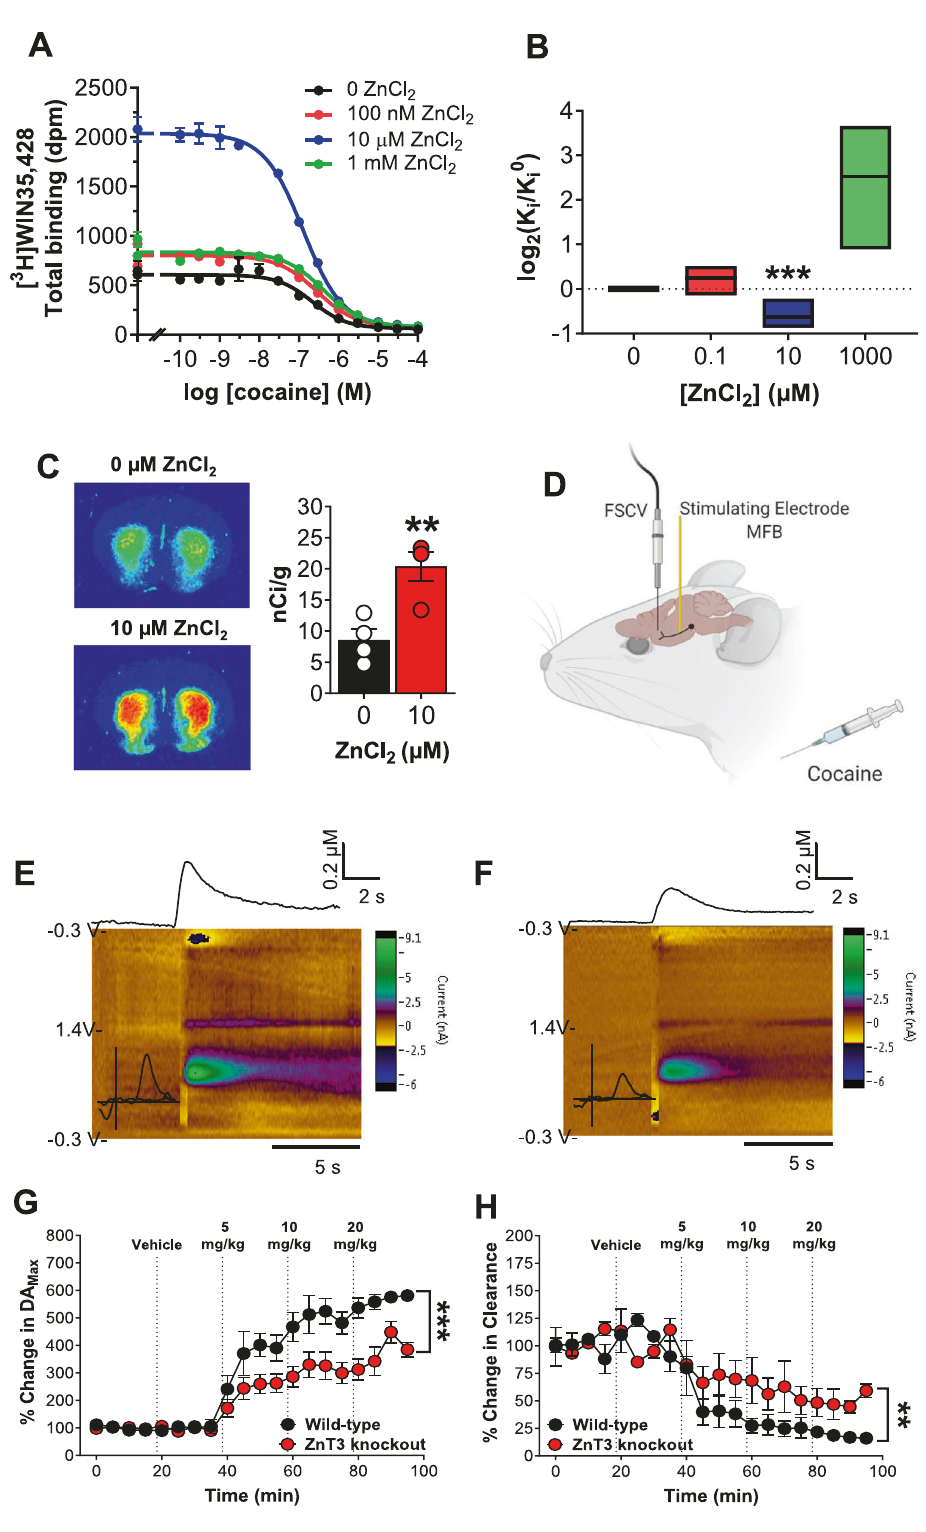
(Fig. 3A, B). In agreement with the above results, 10 µM Zn 2 + also signi fi cantly increased binding of [ 3 H]WIN-35,428 to the DAT in tissue sections ( n = 4 mice) (unpaired t -test, t = 4.03; p = 0.007) (Fig. 3C). To assess cocaine ’ s in vivo effects at the DAT as a function of synaptic Zn 2 + , we performed in vivo FSCV in the striatum of WT (